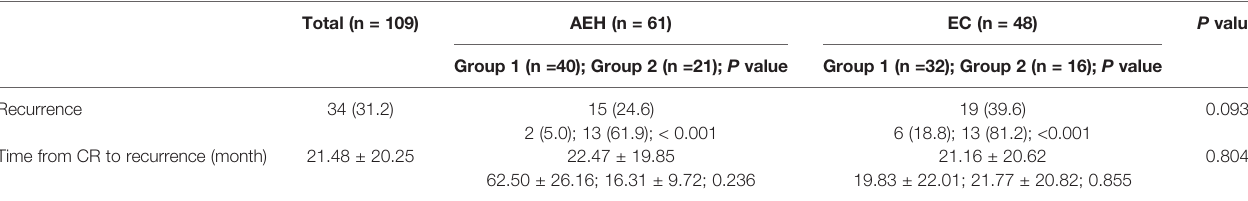
TABLE 3 | Recurrence comparison of atypical endometrial hyperplasia and endometrial cancer (%).